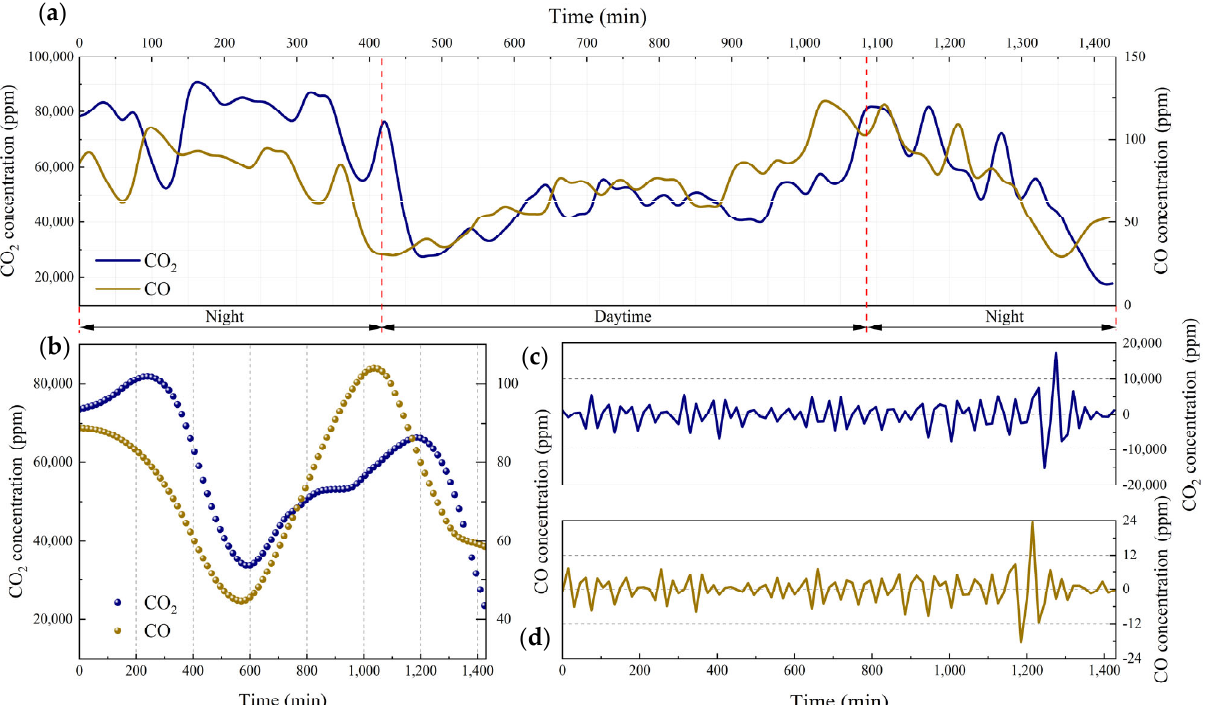
Figure 3. Characteristic diagram of spontaneous combustion gas variation in fissure channel 1# of research point. ( a ) Concentration time change rule; ( b ) Variation characteristics of low − frequency eigenvalues; ( c ) Variation characteristics of high − frequency eigenvalues of CO 2 ; ( d ) Variation characteristics of high − frequency eigenvalues of CO.